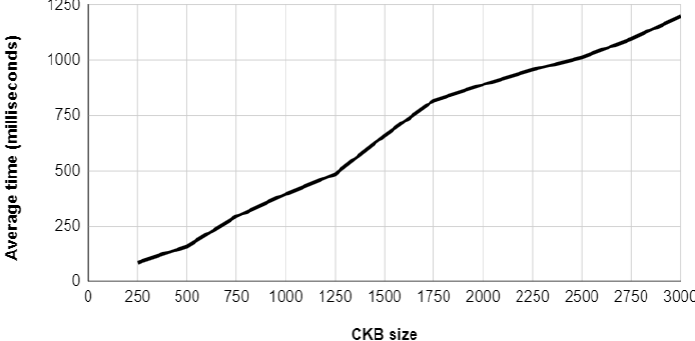
Figure 5. Average execution time of the proposed learning method when facing larger